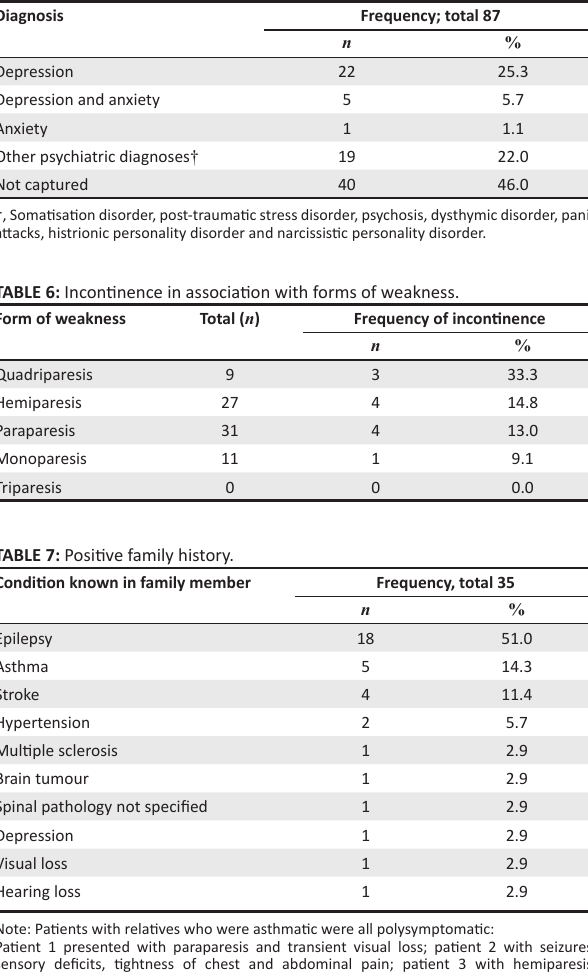
TABLE 5: Psychiatric diagnoses in patients with functional neurological disorders. TABLE 4: Clinical signs suggestive of functional neurological disorders.